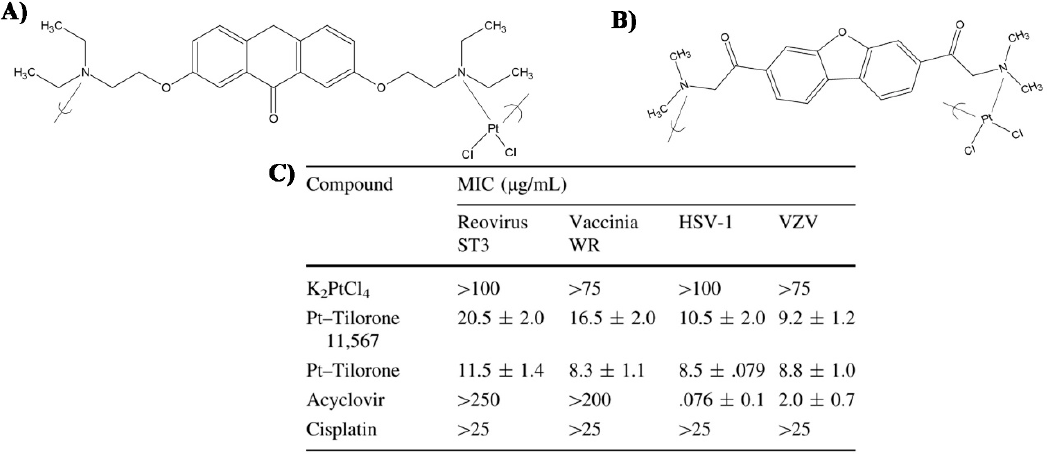
Figure 2. ( A ) Chemical structure of the Tilorone-based polymer; ( B ) Chemical structure of the Tilorone 11,567-based polymer; ( C ) Comparison of antiviral effect of commercial antiviral drugs and new polymers synthesized by Carraher et al., MIC - Minimum Inhibitory Concentration required to reduce virus plaque number by 50%. Reprinted with permission from Roner MR, Carraher CE, Dhanji S, Barot G. Antiviral and anticancer activity of cisplatin derivatives of Tilorone. J Inorg Organomet